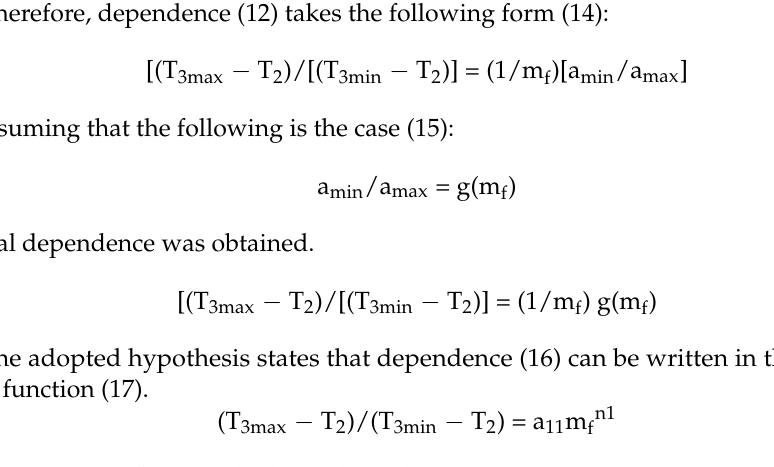
Figure 4. Adopted criteria for evaluating the properties of synthetic components in the Jet A-1 mineral fuel on the combustion process in a miniature turbine engine: (i) distribution of combustion process temperature (T 3 ) and (ii) CO content in exhaust gases (CO).